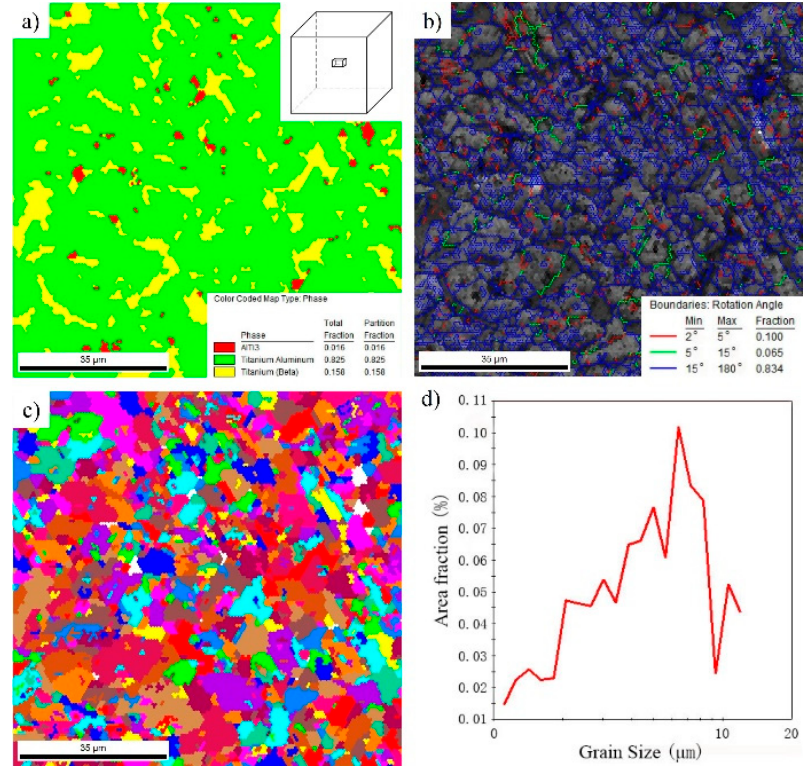
Figure 7. Electron back-scattered di ff raction (EBSD) maps showing the microstructure of Ti-43Al-2Cr-1.5Mn-0.2Y alloy produced in three-steps forging. ( a ) Phase composition, ( b ) grain boundary characteristic, ( c ) grain map, and ( d ) grain size